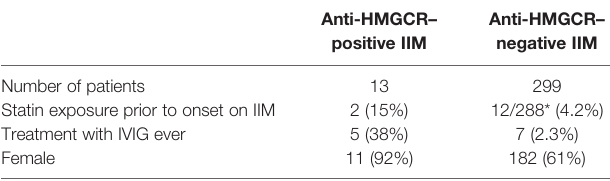
TABLE 1 | Comparison between anti-HMGCR – positive and anti-HMGCR – negative